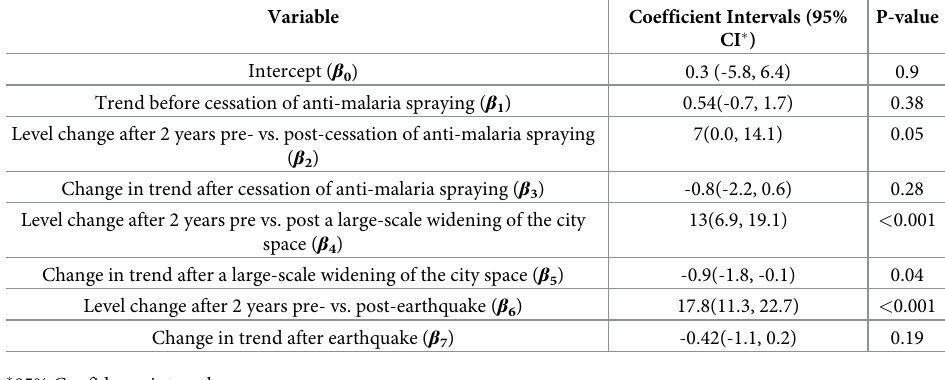
Table 3. Interrupted time series parameters to evaluate trends in incidence per 1,000 of cutaneous leishmaniasis in Bam, southeastern Iran (1971–2020).